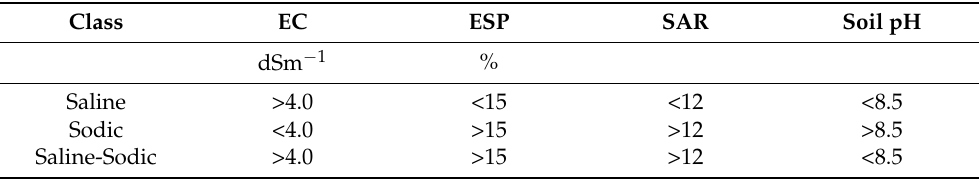
Table 1. Classification of salt-affected soils.